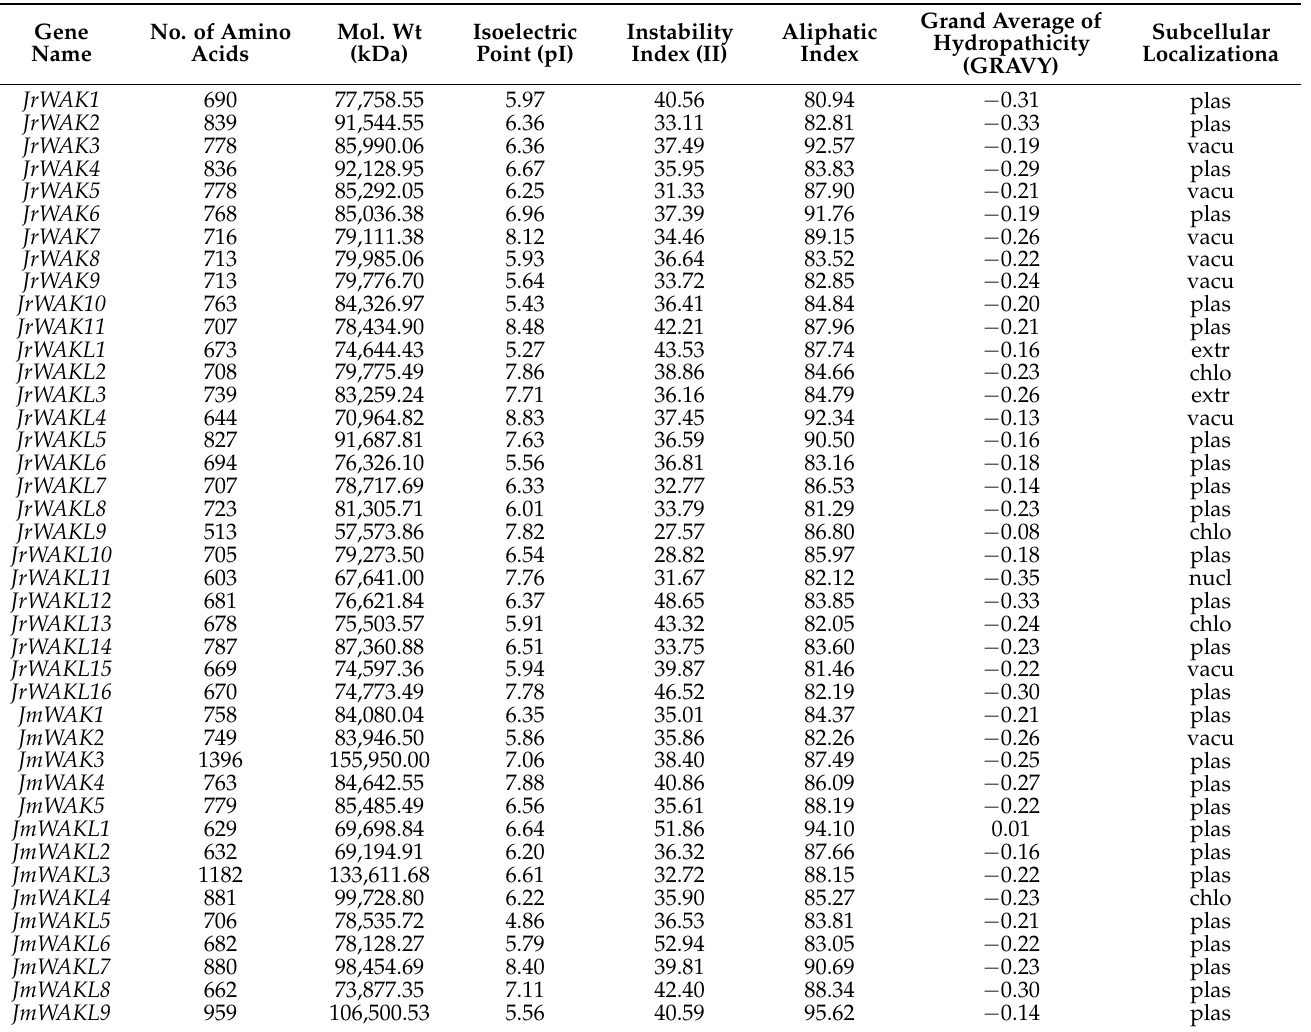
Table 1. The predicated protein information of WAK/WAKL in J. regia and J. mandshurica